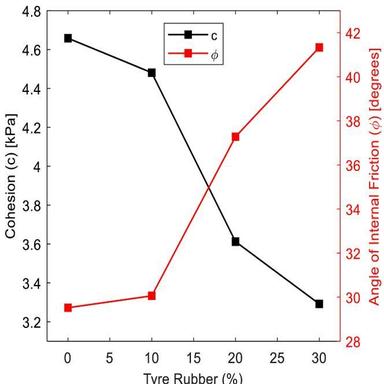
Shear Force-Shear displacement curve for sand and sand-tyre mixes, (a) Sand (b) Sand + 10 % TR (c) Sand + 20 % TR (d) Sand + 30 % TR.